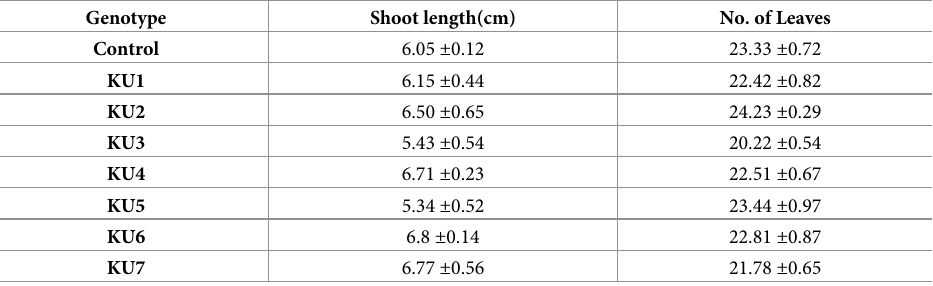
Table 2. Shoot length (cm) and number of leaves in non-transgenic and transgenic plants of Stevia rebaudiana on fourth week of